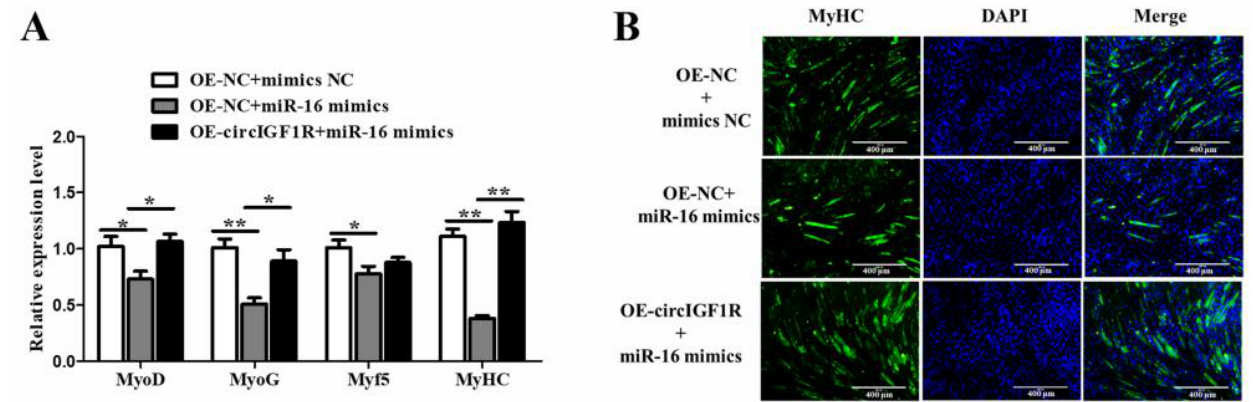
Figure 7. CircIGF1R promotes myoblast differentiation of SMSCs via miR-16. ( A ): Expression changes of key myogenic factors after transfection with OE-NC+mimics NC, OE-NC+miR-16 mimics, and OE-circIGF1R+miR-16 mimics. ( B ): Immunofluorescence staining results after trans- fection with OE-NC+mimics NC, OE-NC+miR-16 mimics, and OE-circIGF1R+miR-16 mimics. Blue indicates nuclei stained with DAPI; green indicates MyHC protein. ** p < 0.01, * p < 0.05.